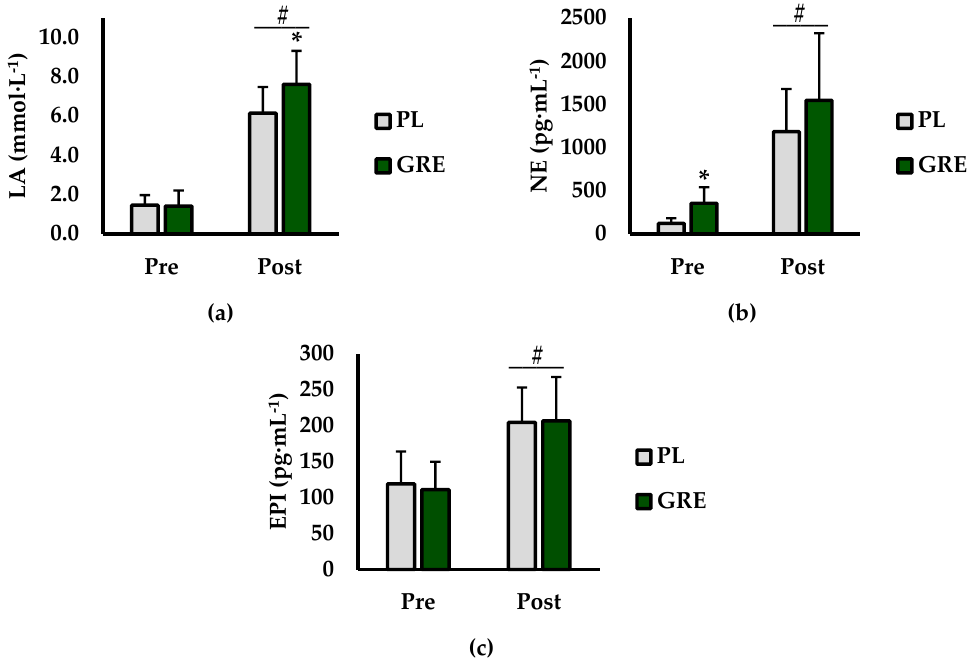
Figure 3. ( a ) Blood lactate (LA; mmol ∙ L − 1 ), ( b ) Plasma Norepinephrine (NE; pg ∙ mL − 1 ), and ( c ) Plasma Epinephrine (EPI; pg ∙ mL − 1 ), compared between placebo (PL; grey bars) and golden root extract (GRE; green bars). Additionally, measurements were taken and compared immediately prior to (Pre) and after (Post) exercise. * indicates significantly different from GRE ( p < 0.05). # indicates significantly different from Pre ( p < 0.05).